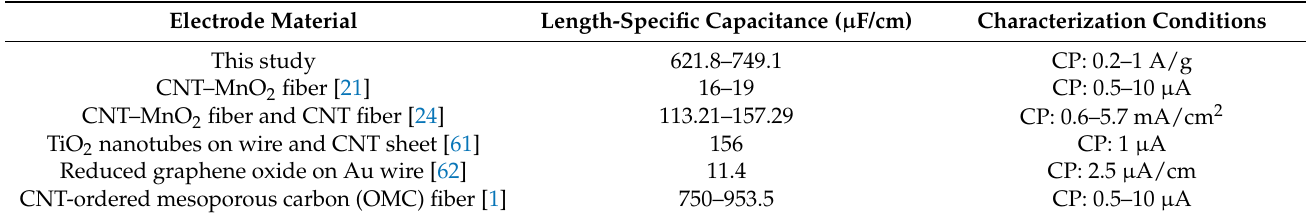
Table 6. Comparison of specific capacitances of wire-shaped